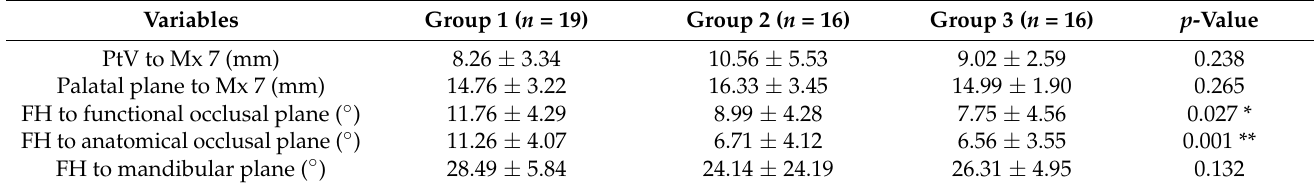
Table 3. Comparison of pre-treatment cephalometric variables between groups.